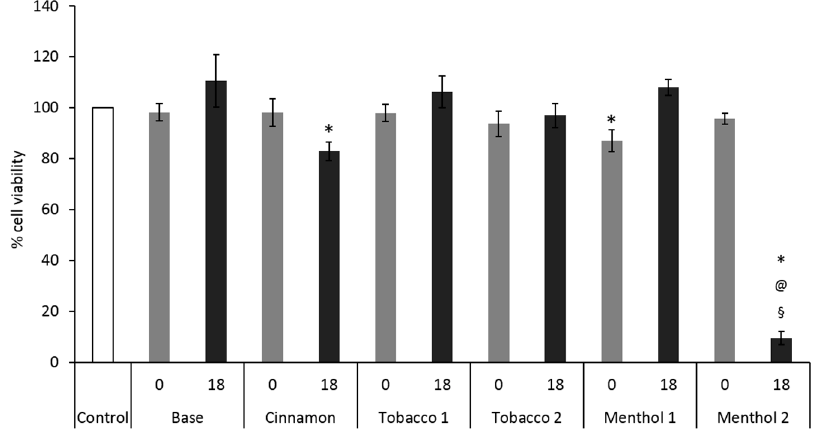
Figure 2. Cytotoxic effects of condensed aerosols (CAs) from e-liquid samples on monoculture A549 cells. MTT viability test was performed after 24 h of exposure to CAs belonging to e-liquids with (18 mg/mL, black bars ) and without ( grey bars ) nicotine. Bars represent the percentage of viable cells with respect to the control (unexposed cells, white bar), considered as 100%. Data are presented as mean±SEM of at least 5 independent experiments. * p < 0.05; unpaired t -test over the control; @ p < 0.05; unpaired t -test over Base 0; § p < 0.05; unpaired t -test over Base 18.